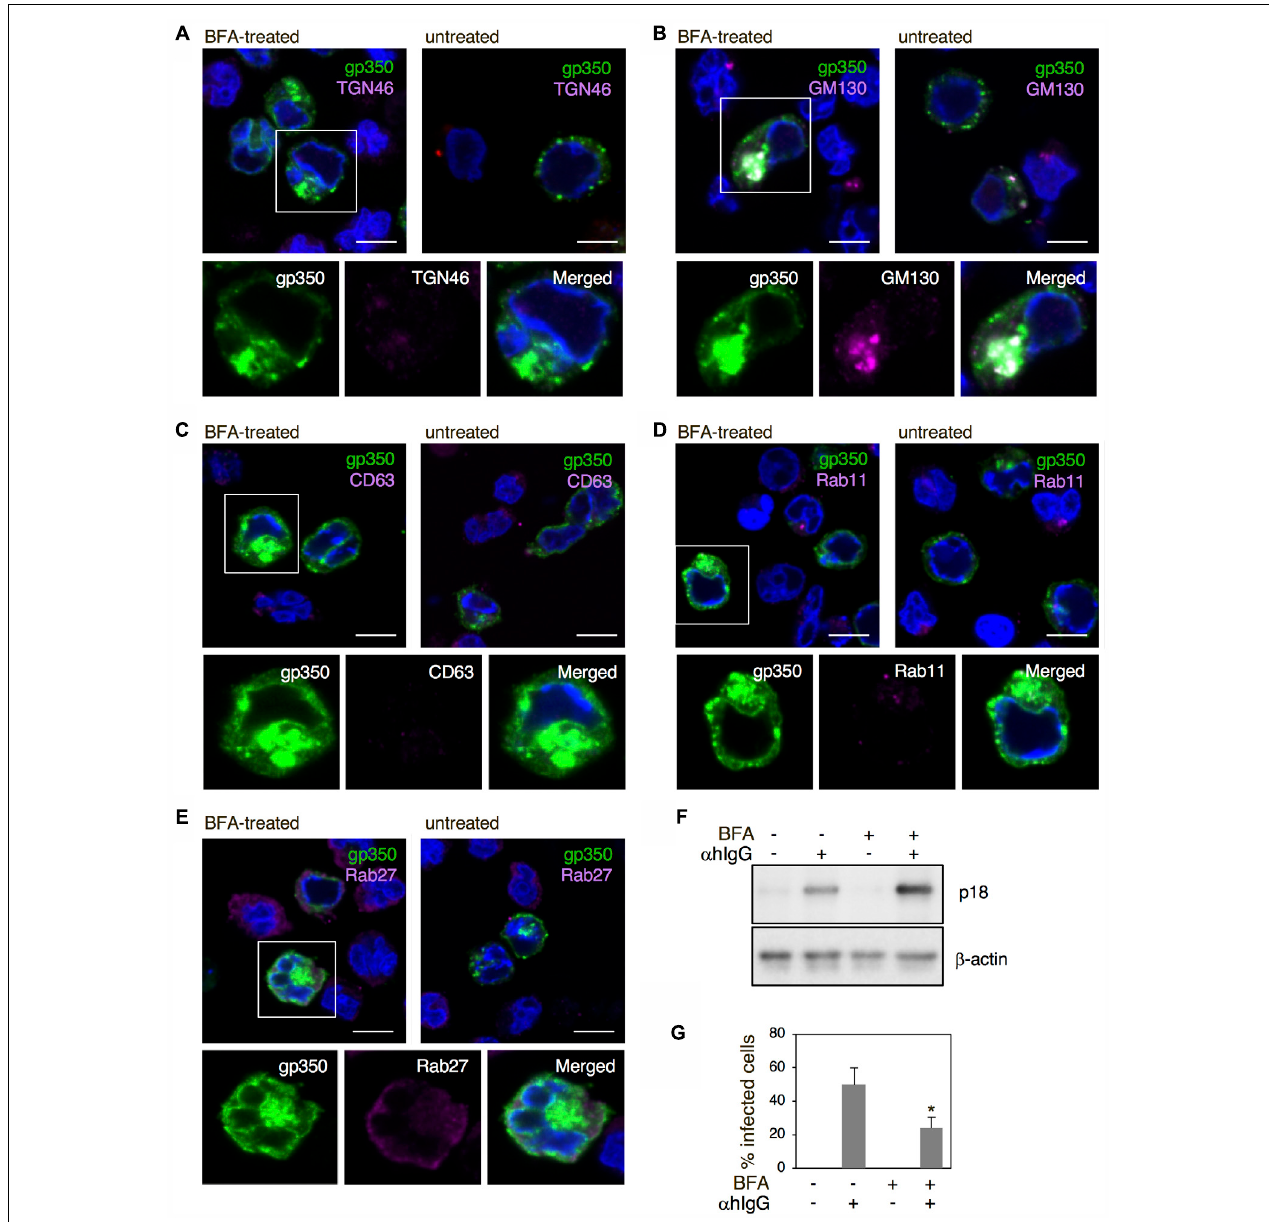
FIGURE 8 | The effect of BFA on the distribution of EBV structural proteins and the release of virions. (A–E) The effect of BFA on the distribution of gp350/220 and organelle markers in Akata + cells induced into the lytic cycle. Akata + cells were treated with α hIgG in the presence or absence of 100 nM BFA for 16 h. The distribution of gp350/220 (green), TGN46 (A) , GM130 (B) , CD63 (C) , Rab11 (D) , and Rab27a (E) are shown. The nuclei were counterstained with Hoechst 33342. Insets show the boxed areas. Scale bars: 10 µ m. (F) The effect of BFA on expression of p18 in Akata + cells undergoing the lytic cycle. Akata + cells were treated with or without α hIgG in the presence or absence of 100 nM BFA for 16 h. Total cell lysates were analyzed by Western blotting with antibodies against p18 or β -actin. (G) The effect of BFA on the release of virions. Akata − eGFP-EBV cells were treated with or without α hIgG in the presence or absence of 100 nM BFA for 48 h. Supernatants containing eGFP-EBV were harvested and incubated with Daudi − cells for 24 h. The percentages of eGFP-positive infected Daudi − cells were analyzed by means of flow cytometry. The experiment was performed three times independently and the average values and their standard deviations are shown for each condition. ∗ P < 0.05 versus respective control (Student’s t